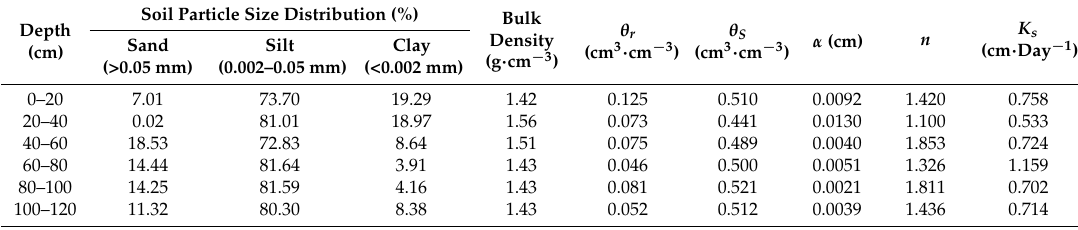
Table 1. Physical properties and calibrated van Genuchten hydraulic parameters of the tested paddy soil in the Taihu Lake